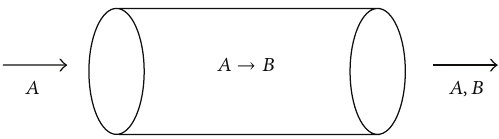
Figure 5: Sketch of a catalytic packed-bed reactor.